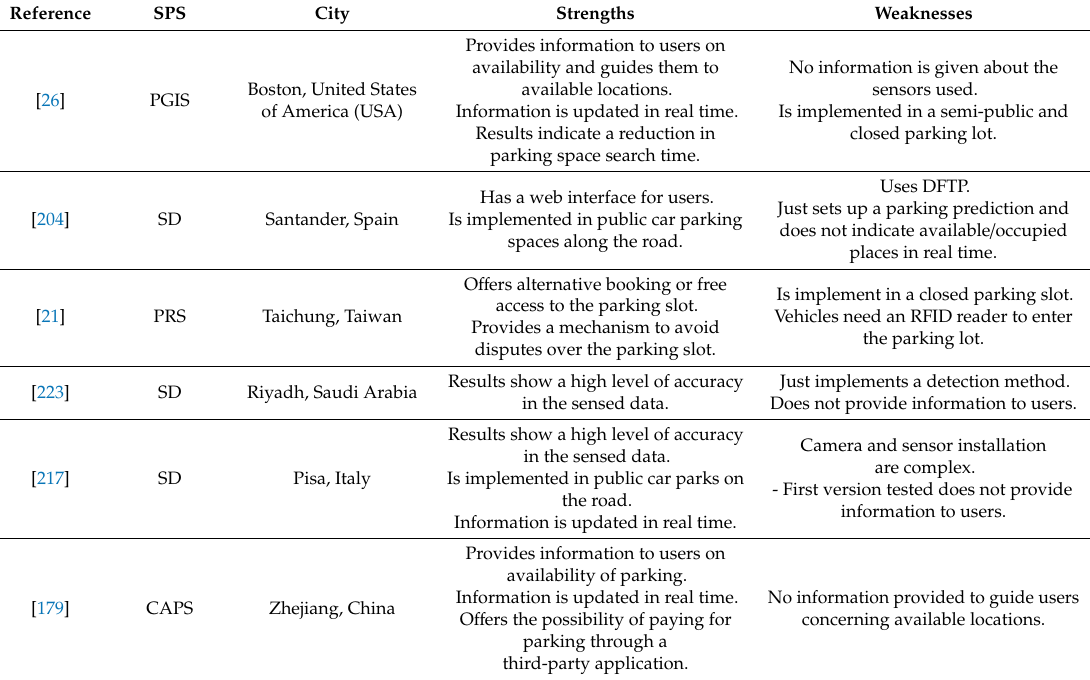
Table 14. Implemented works: principal strengths and